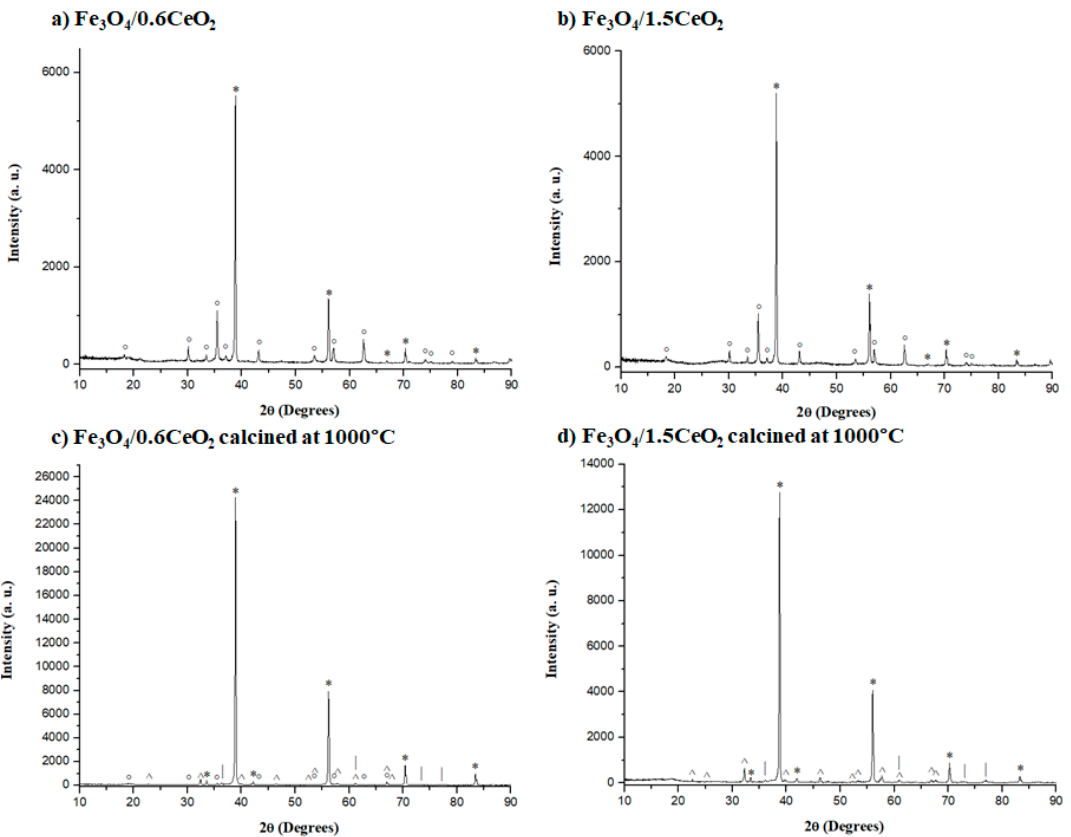
Figure 4. XRD patterns of ( a ) Fe 3 O 4 / 0.6CeO 2 , ( b ) Fe 3 O 4 / 1.5CeO 2 , ( c ) Fe 3 O 4 / 0.6CeO 2 and ( d ) Fe 3 O 4 / 1.5CeO 2 calcined at 1000 ◦ C. The marked peaks belong to: * NaF (support), ◦ magnetite, ˆ cerium ferrite and | wüstite.